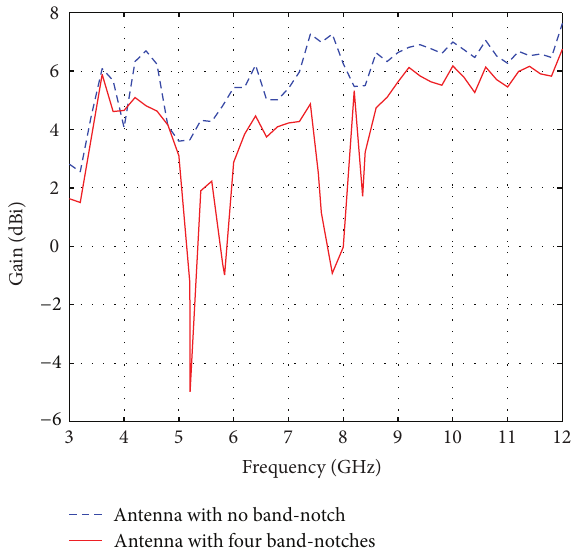
Figure 7: Measured peak gain over the frequency